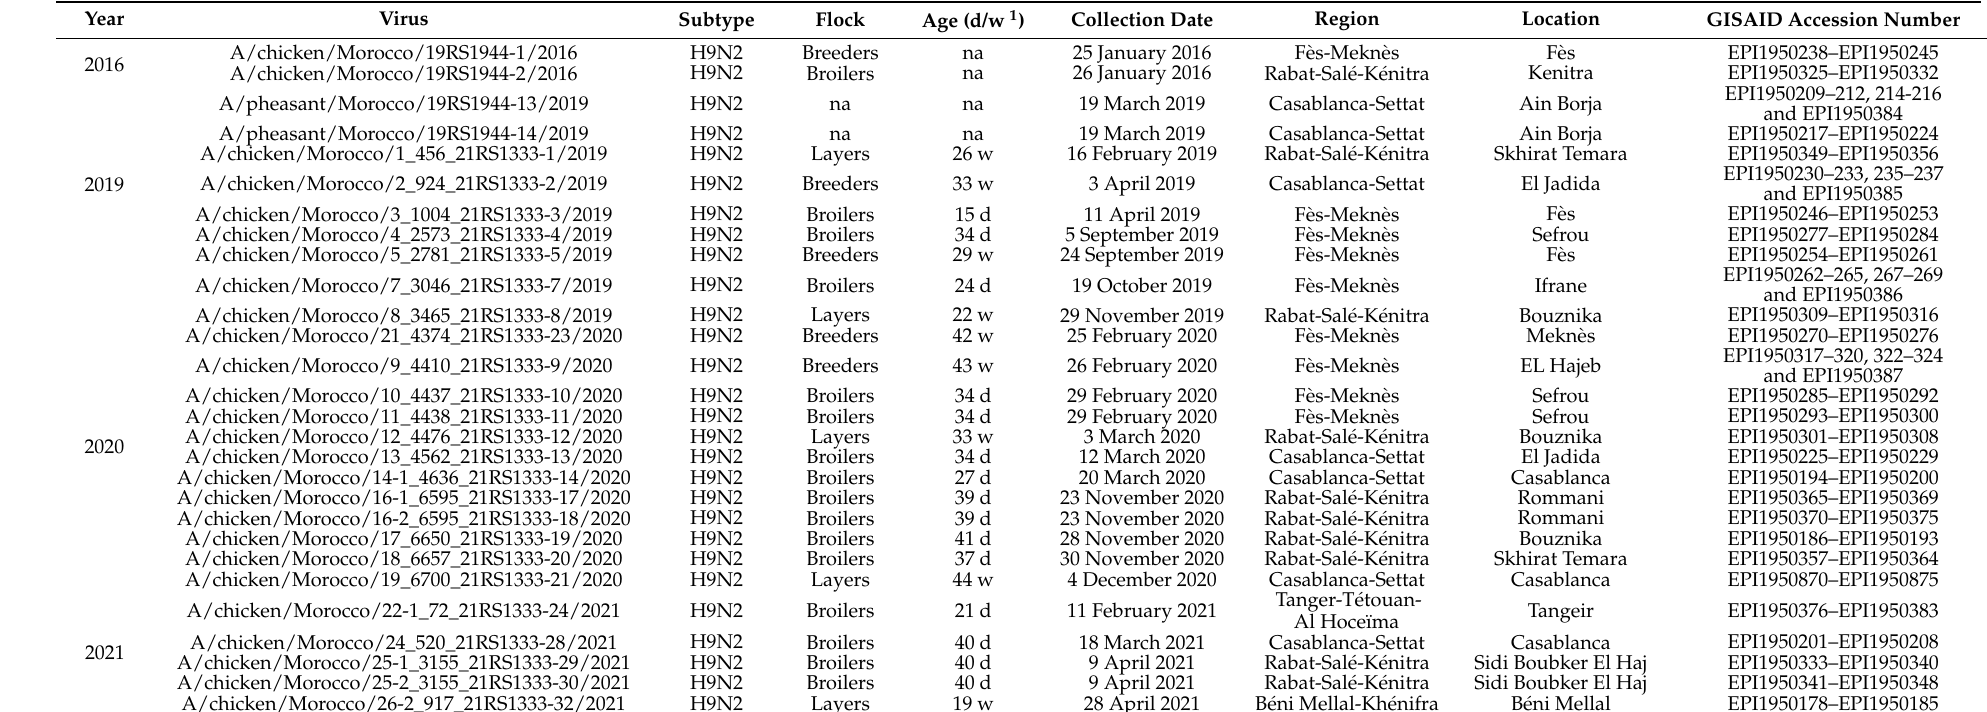
Table 1. H9N2 isolates related information and GISAID accession